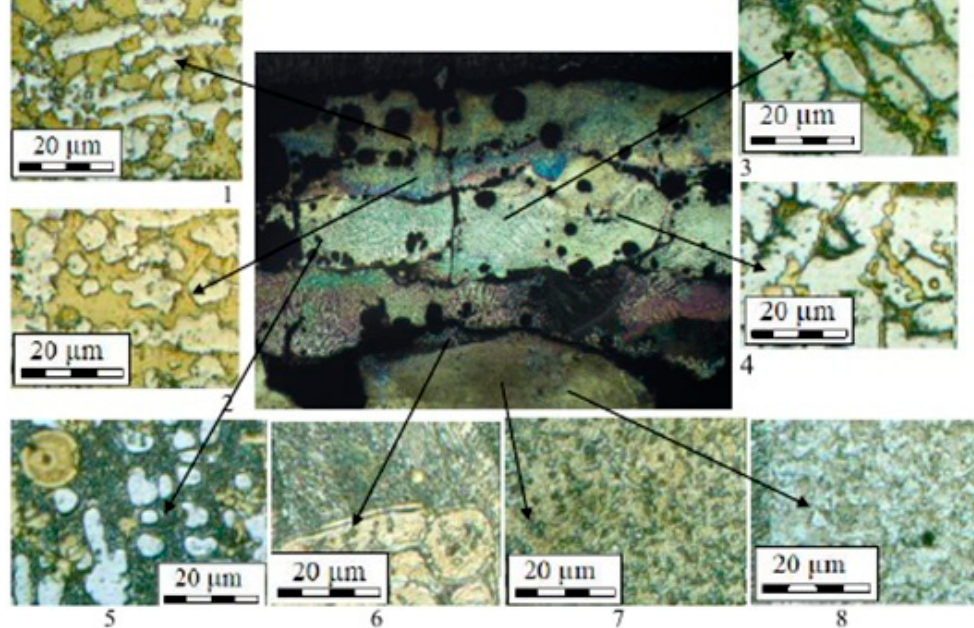
Figure 3. Optical micrographs and microhardness behavior of the DED of a Ti-Fe-graded layered sample produced by the 1st mode.